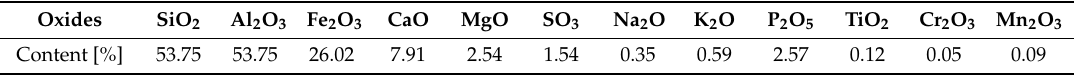
Table 2. The composition of the ash from the Mintia thermal power plant, determined by XRF (X-ray fluorescence) analysis.